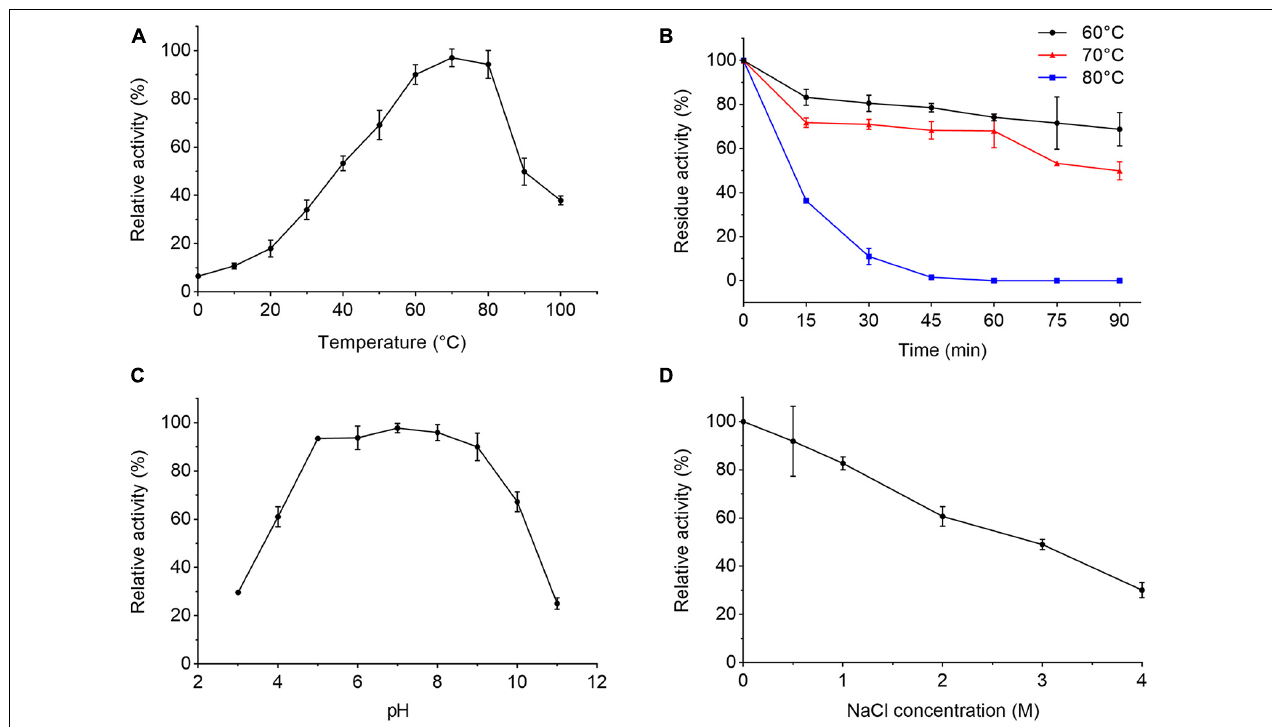
FIGURE 2 | Characterization of the extracellular protease of strain 1A02591. (A) Effect of temperature on the protease activity. The protease activity was measured in 50 mM Tris-HCl buffer (pH 7.5) from 0 ◦ C to 100 ◦ C. (B) Effect of temperature on the protease stability. The residue activity of the protease was measured after the protease was incubated at 60, 70, or 80 ◦ C for different times. (C) Effect of pH on the protease activity. The protease activity was determined at 70 ◦ C in Britton-Robinson buffers at pH values ranging from 3 to 11. (D) Effect of NaCl concentration on the protease activity. The protease activity was determined at 70 ◦ C with a NaCl concentration from 0 to 4 M. The graphs show data from triplicate experiments (mean ± SD).